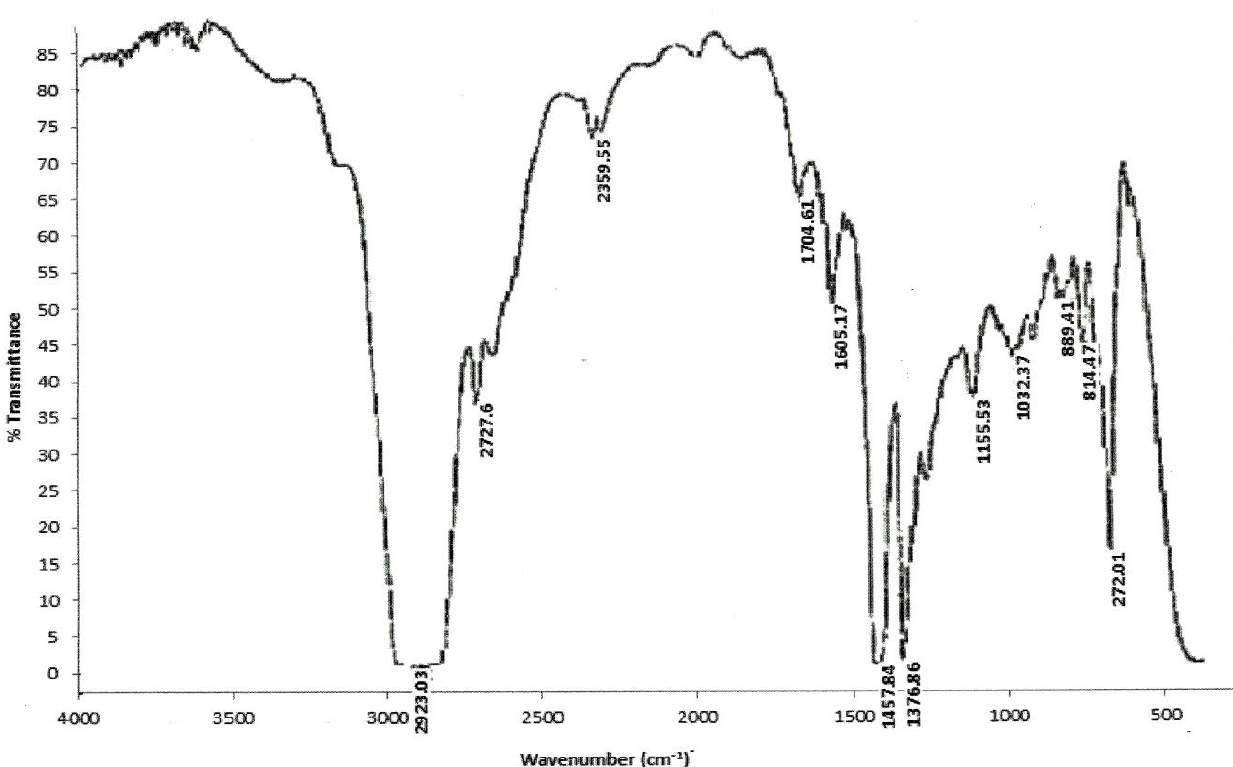
Figure 4. Results of analysis of the used engine oil.